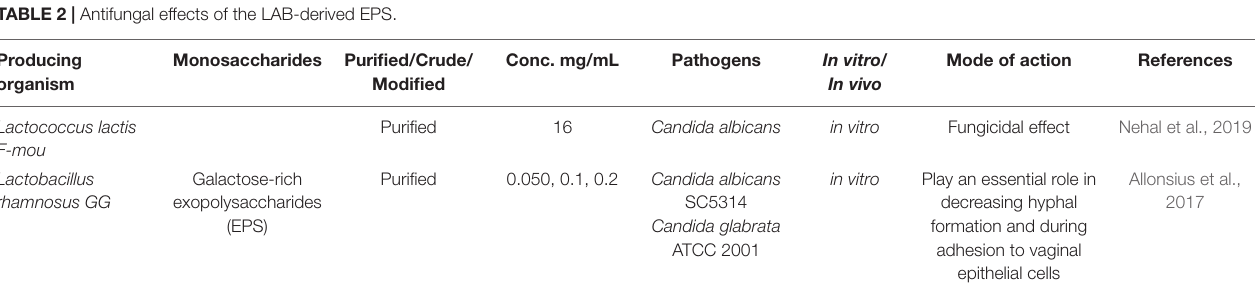
TABLE 2 | Antifungal effects of the LAB-derived